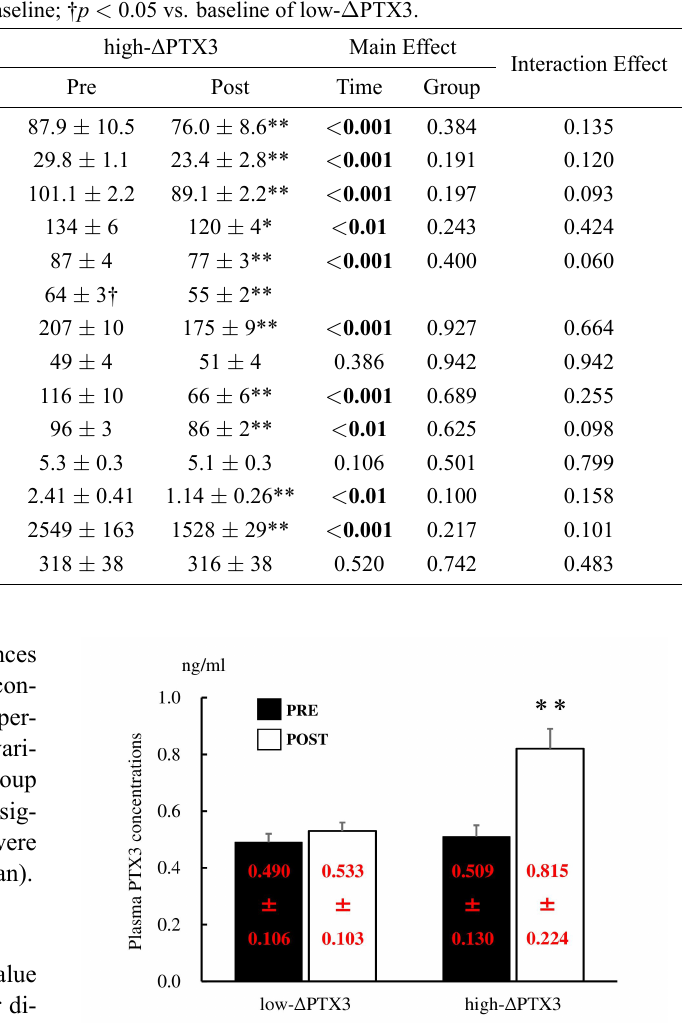
Table 1. Changes of characteristics before and after lifestyle modification in low- ∆ PTX3 and high- ∆ PTX3 groups. Mean ±